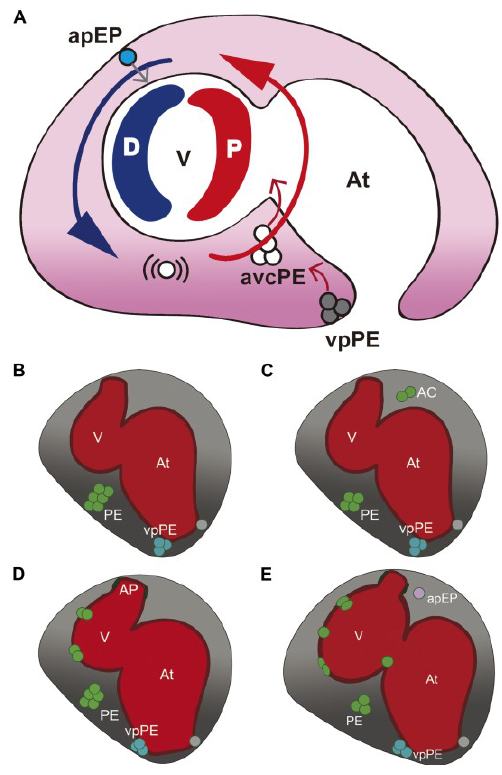
Figure 1. Schematic representation of epicardium formation in the zebrafish. ( A ) The model describing the influence of the heartbeat on proepicardium (PE) cluster formation and epicardium morphogenesis. Pericardial fluid flow advects released PE cells around the ventricle until they attach to it. Large blue and red arrows indicate flow direction and flow force (blue, low force; red, high force). Small red arrows indicate the release of cells from the PE clusters; the small gray arrow indicates the transfer of epicardial precursor cells to the myocardium. ( B – E ) The time frame of events leading to epicardium formation in the zebrafish. ( B ) At 55 hours postfertilization (hpf), a large PE cluster emerges from the mesothelial wall close to the atrioventricular canal of the forming heart. While two-sided expression of Epi:green fluorescent protein (GFP)-positive cells can be observed before 60 hpf, only the right venous pole PE (vpPE) cluster forms. ( C ) Over the next 10–12 hours, cells from these clusters are released into the pericardial cavity (gray shading). ( D ) Advected cells adhere first to the distal ventricle and later to the proximal part. ( E ) Once attached, epicardial cells proliferate and subsequently flatten. Single cells delaminate from the cranial pericardial mesothelium (arterial pole epicardial precursor pool (apEP)) and are transferred to the ventricular surface. The outflow tract of the heart is covered by pericardial mesothelial cells, which are not derived from the PE clusters. AC, advected cells; apEP, arterial pole epicardial precursor cell; At, atrium; avcPE and PE, atrioventricular canal proepicardial cluster; D, distal; P, proximal; V, ventricle; vpPE, venous pole proepicardial cluster. Images adapted from the original article in Current Biology